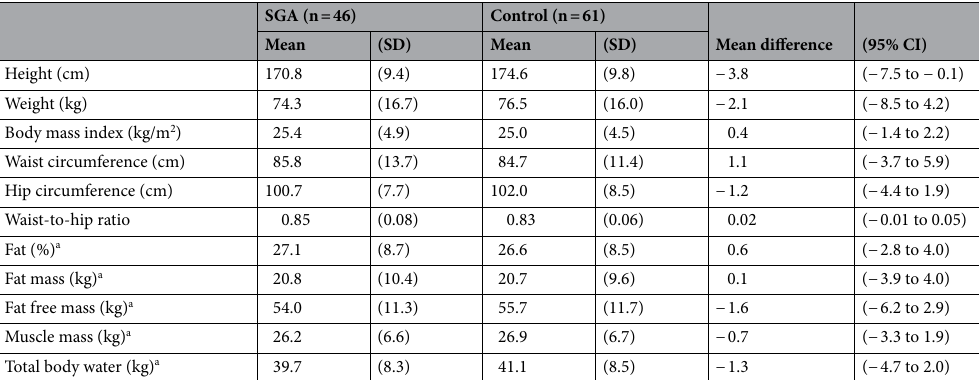
Table 2. Anthropometric measures and bioelectrical impedance analysis of adults born small for gestational age (SGA) and non-SGA (control) at term. CI confidence interval, SD standard deviation, SGA small for gestational age. a Data missing for two participants born SGA and three controls due to pregnancy, uncertainty about pregnancy and a nerve stimulator implant to treat chronic